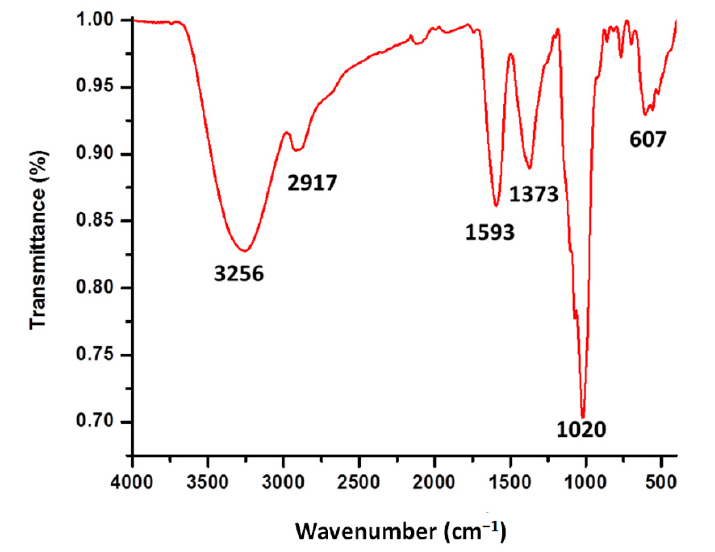
Figure 4. FTIR spectra of synthesized CuONPs.